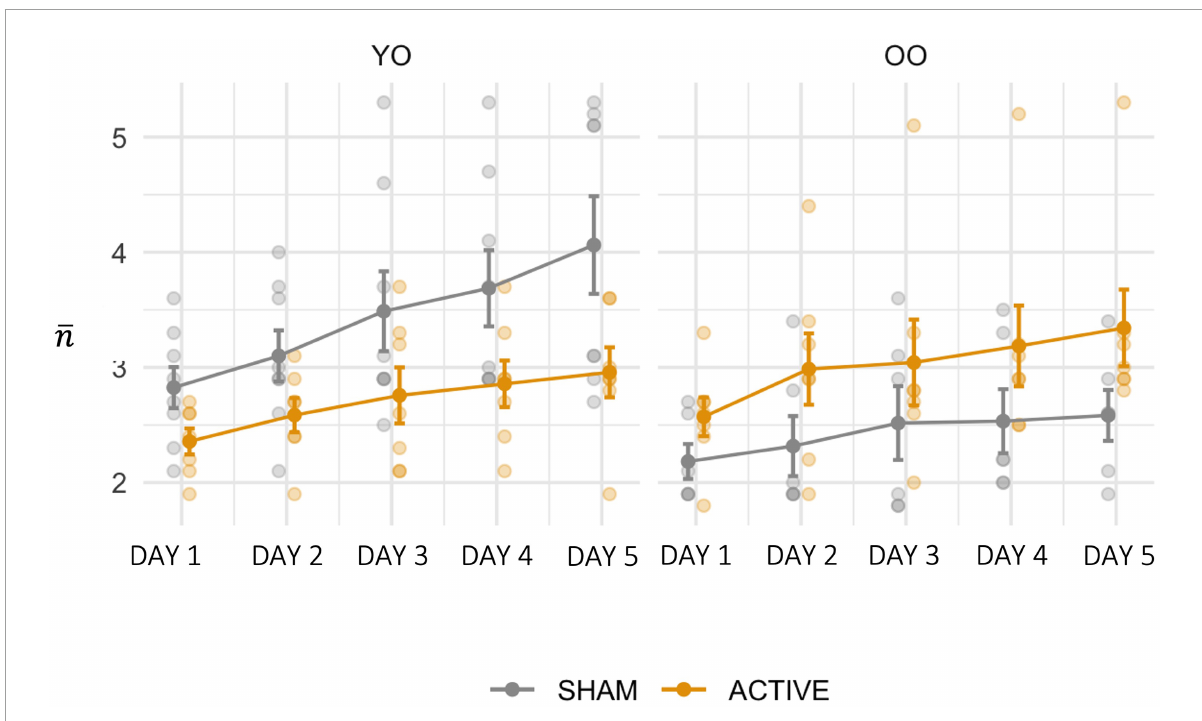
FIGURE3 Training performance ( ¯ n ) for each training day, for the SHAM and ACTIVE groups, within each AGE level. Error bars represent the standard error of the mean.